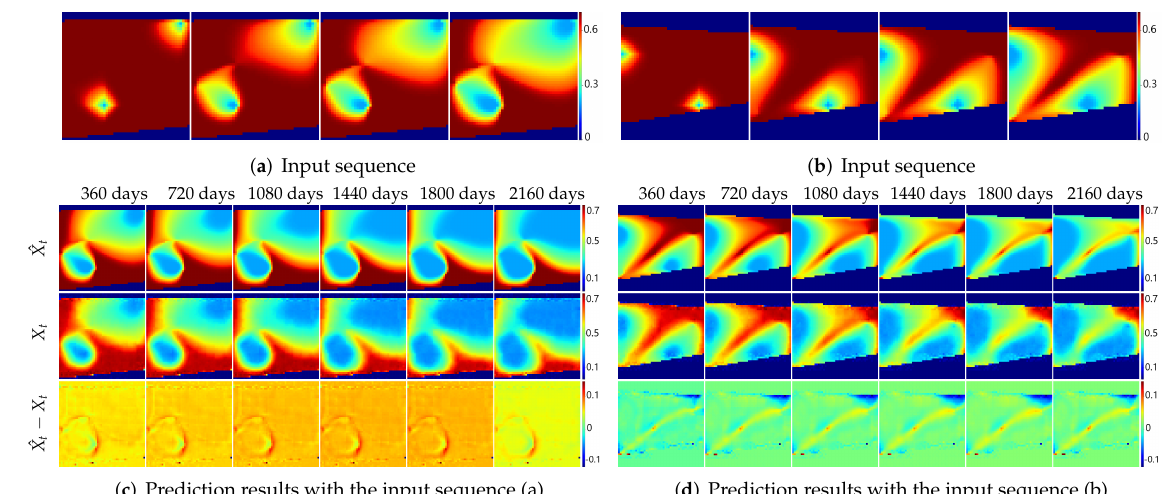
Figure 8. Prediction examples.